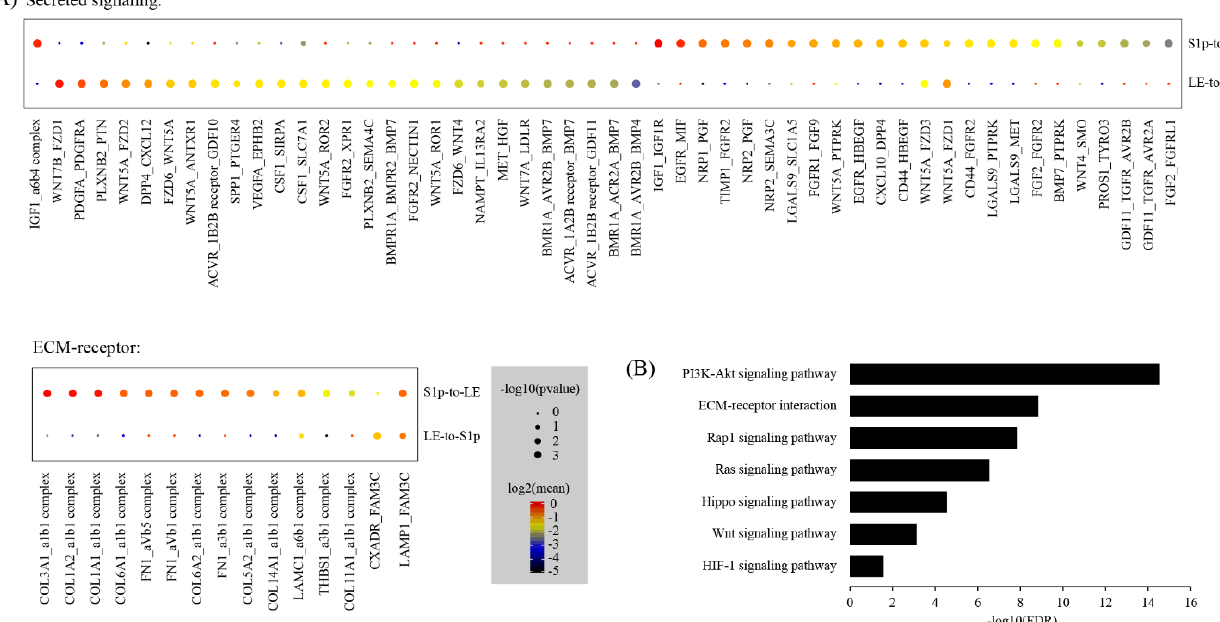
Figure 8. Cell–cell communication between LE and S1p: ( A ) dot plot showing selected ligand–receptor interactions underlying LE-S1p crosstalk; ( B ) KEGG Pathway enrichment analysis of ligand–receptor pairs.